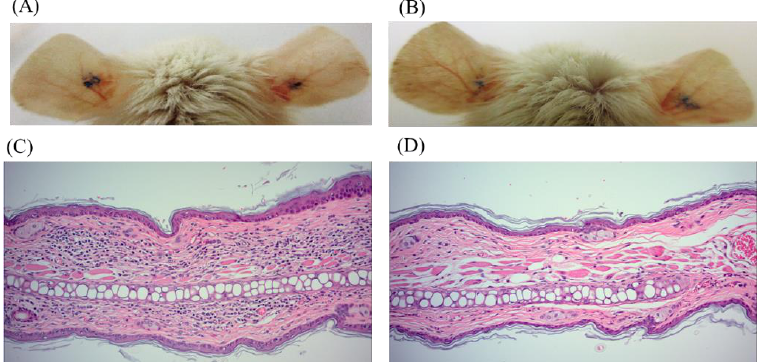
Figure 3. In vivo anti-inflammatory activity of cinnamtannin B1 ( 19 ). P. acnes was intradermally injected into the ears at the blue-marked positions, and phosphate-bu ff ered solution (PBS) or 19 (20 mg / kg) were administered intraperitoneally daily for 4 days starting right after the infection. Representative photos of mice ( A ) PBS-treated and ( B ) 19 -treated 24 h after the infection. ( C ) A PBS-treated histology section (H&E staining) ( D ) a 19 -treated histology section (H&E staining) on day 5 after the infection. The sections were 200 ×